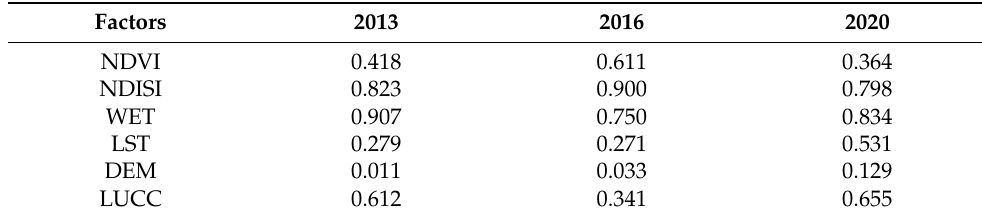
Table 4. Single-factor detection